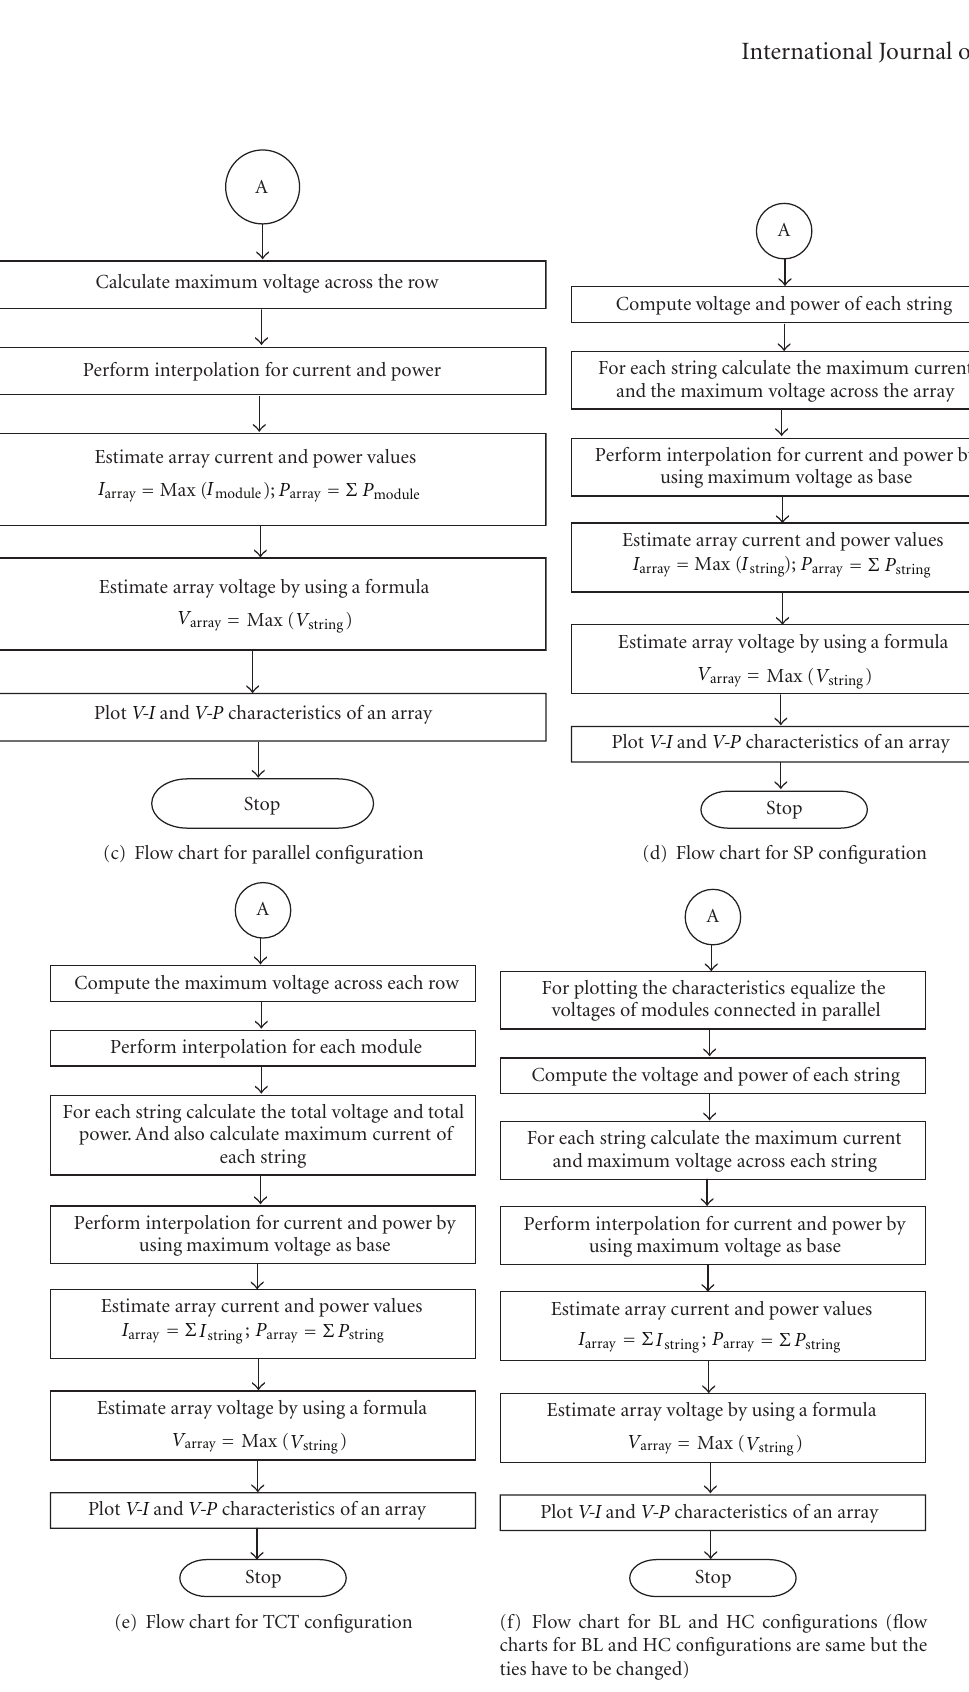
Figure 5: Flowchart for coding all the